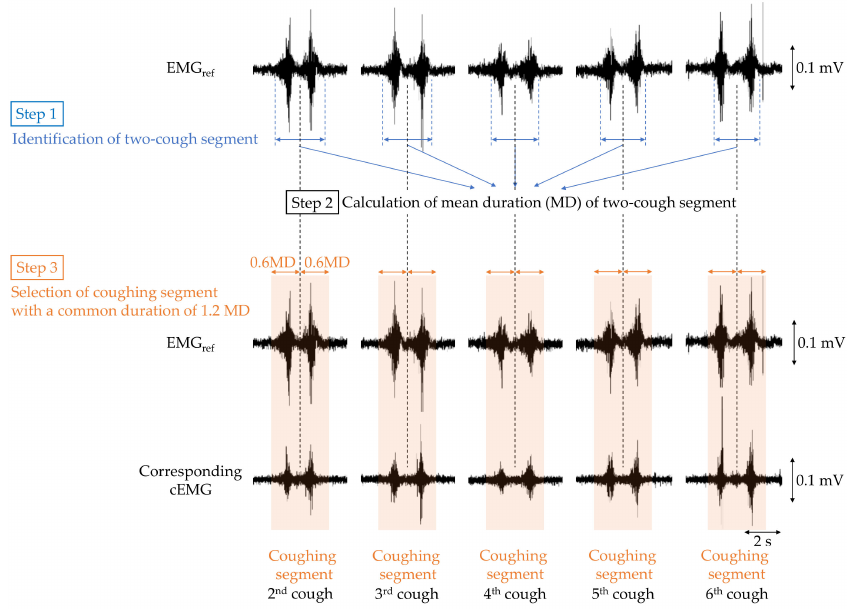
Figure 4. Flowchart of selecting the coughing segment in the EMG ref and cEMG data for the following discrete-time Fourier transform (DFT)